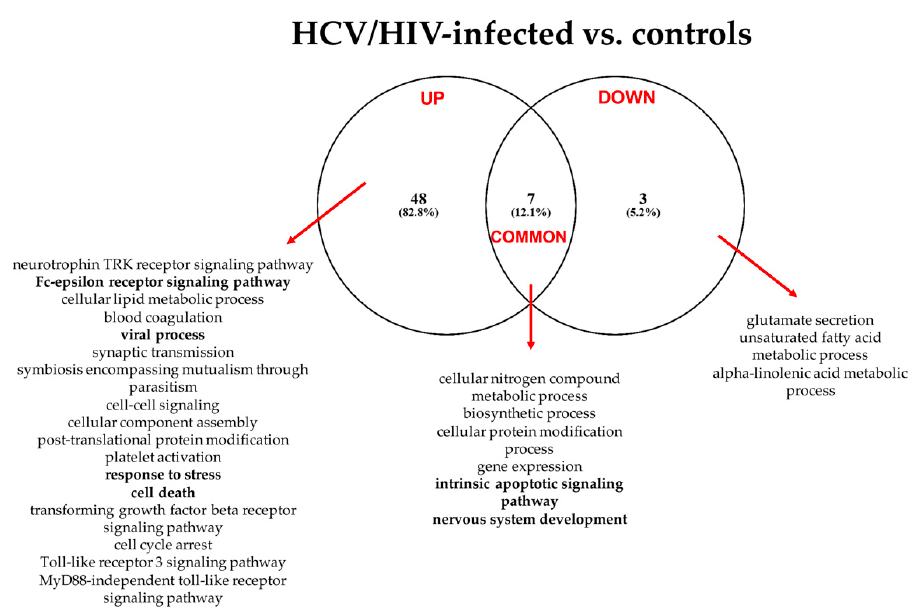
Figure 4. Summary of the “Gene Ontology-Biological Process” enriched functional terms associated with the predicted gene targets of the miRNAs differentially expressed between LB obtained from HCV/HIV co-infected patients vs. healthy livers. Some of the most relevant biological processes are shown; the complete lists of enriched terms are available in Supplementary Table S9A.